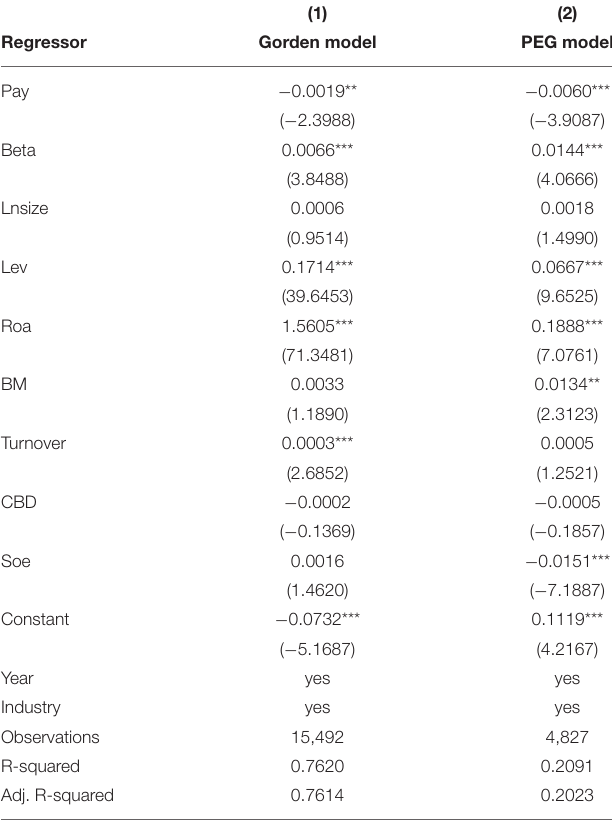
TABLE 5 | Executive incentive and the equity